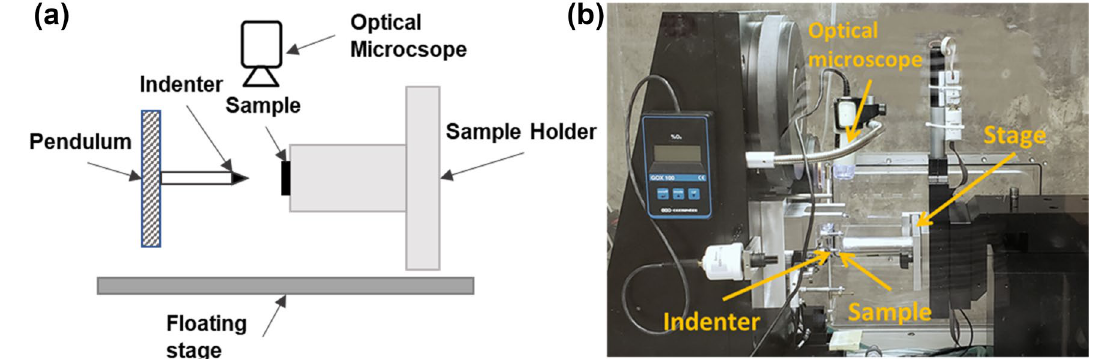
Fig. 3 Nanoindentation experiment setup